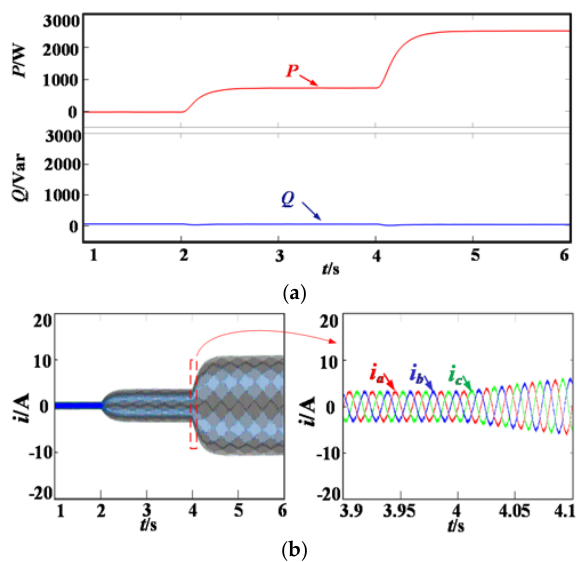
Figure 7. Wind ‐ speed influence on generator ‐ side and grid ‐ side parameters. ( a ) Active and reactive power; ( b ) grid ‐ side three ‐ phase current, current local